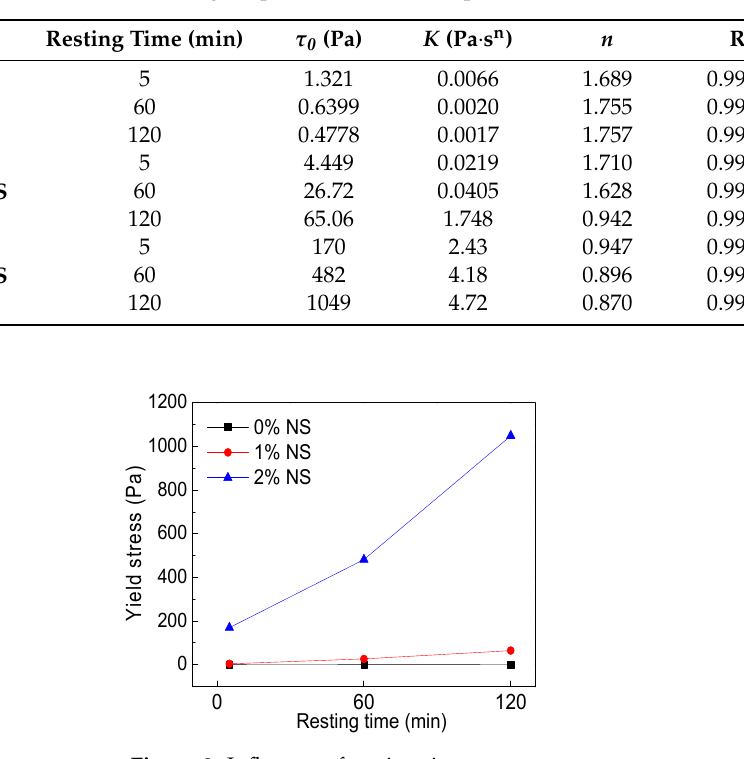
Figure 8. Influence of resting time on τ 0 . Table 4. Rheological parameters of C–FA paste with NS.